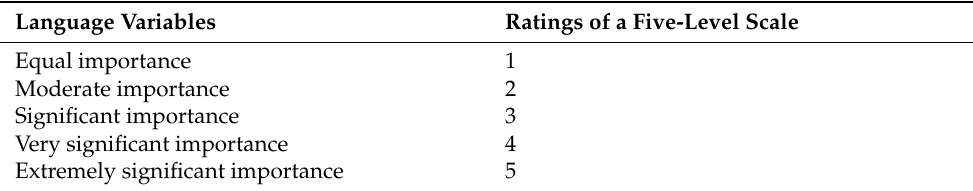
Table 2. Five-level scale and the corresponding language